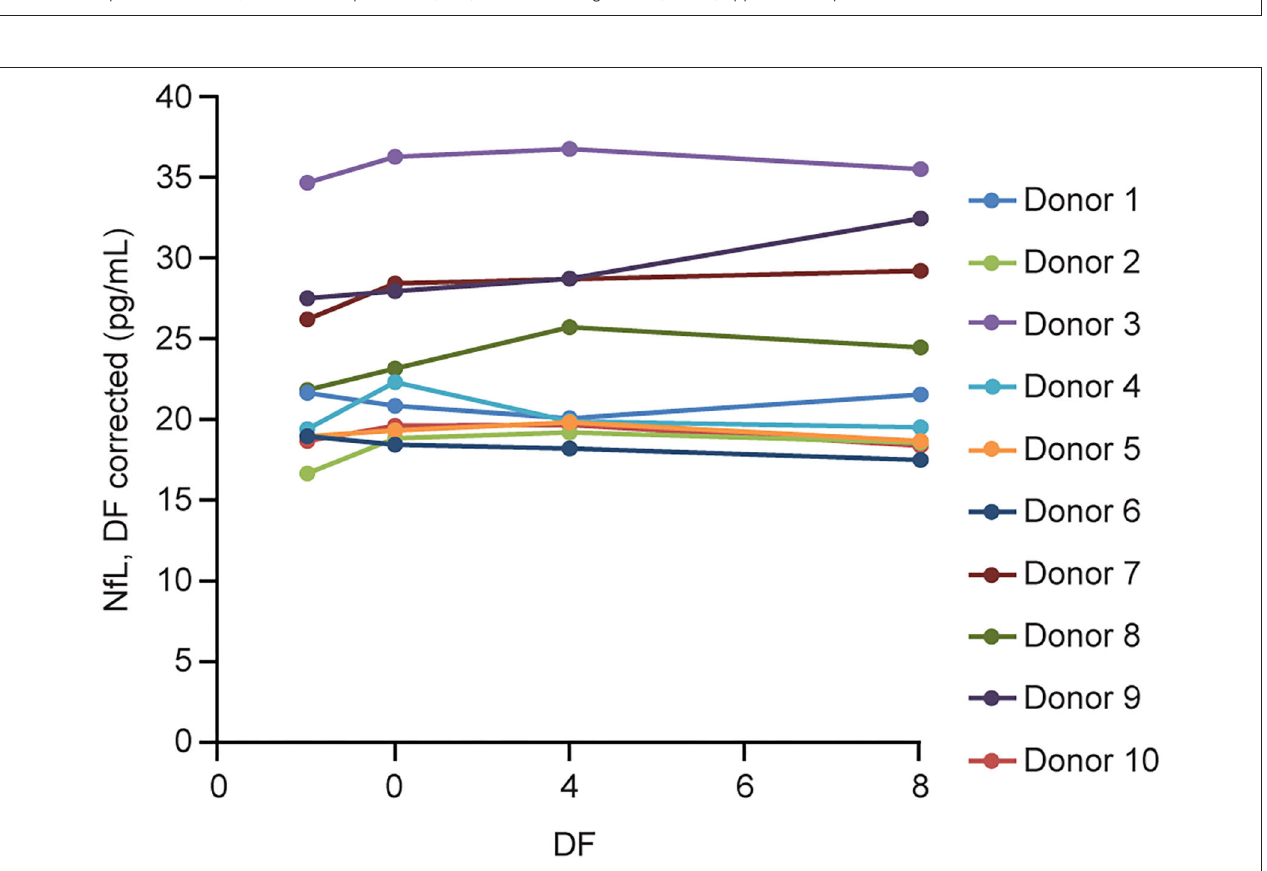
FIGURE 4 | Serum parallelism. Ten individual serum samples with endogenous NfL levels > 16 pg/mL (up to 35 pg/mL) were tested neat and serially diluted 2, 4, and 8 × using NfL sample diluent. DF, dilution factor; NfL, neurofilament light chain.